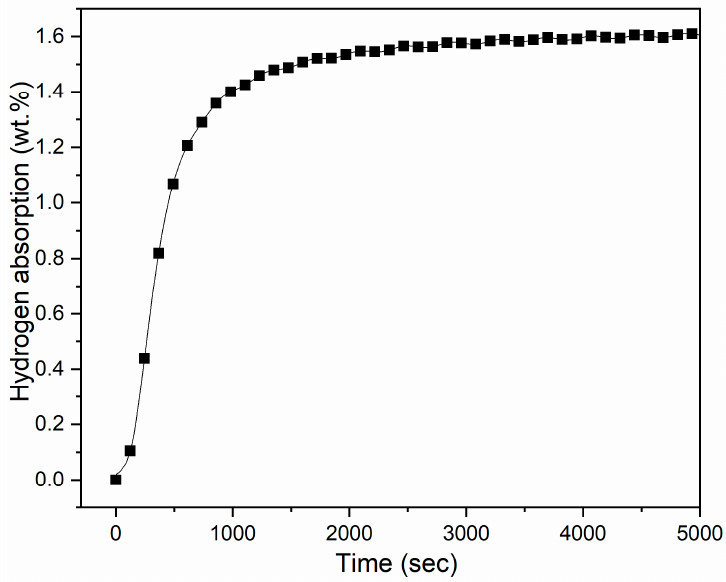
Figure 4. Activation curve of as-cast Ti 0.3 V 0.3 Mn 0.2 Fe 0.1 Ni 0.1 alloy. The alloy absorbs hydrogen, reaching a maximum capacity of 1.6 wt.% within one hour. Even if the alloy is multiphase, the activation curve seems to behave as a single- phase